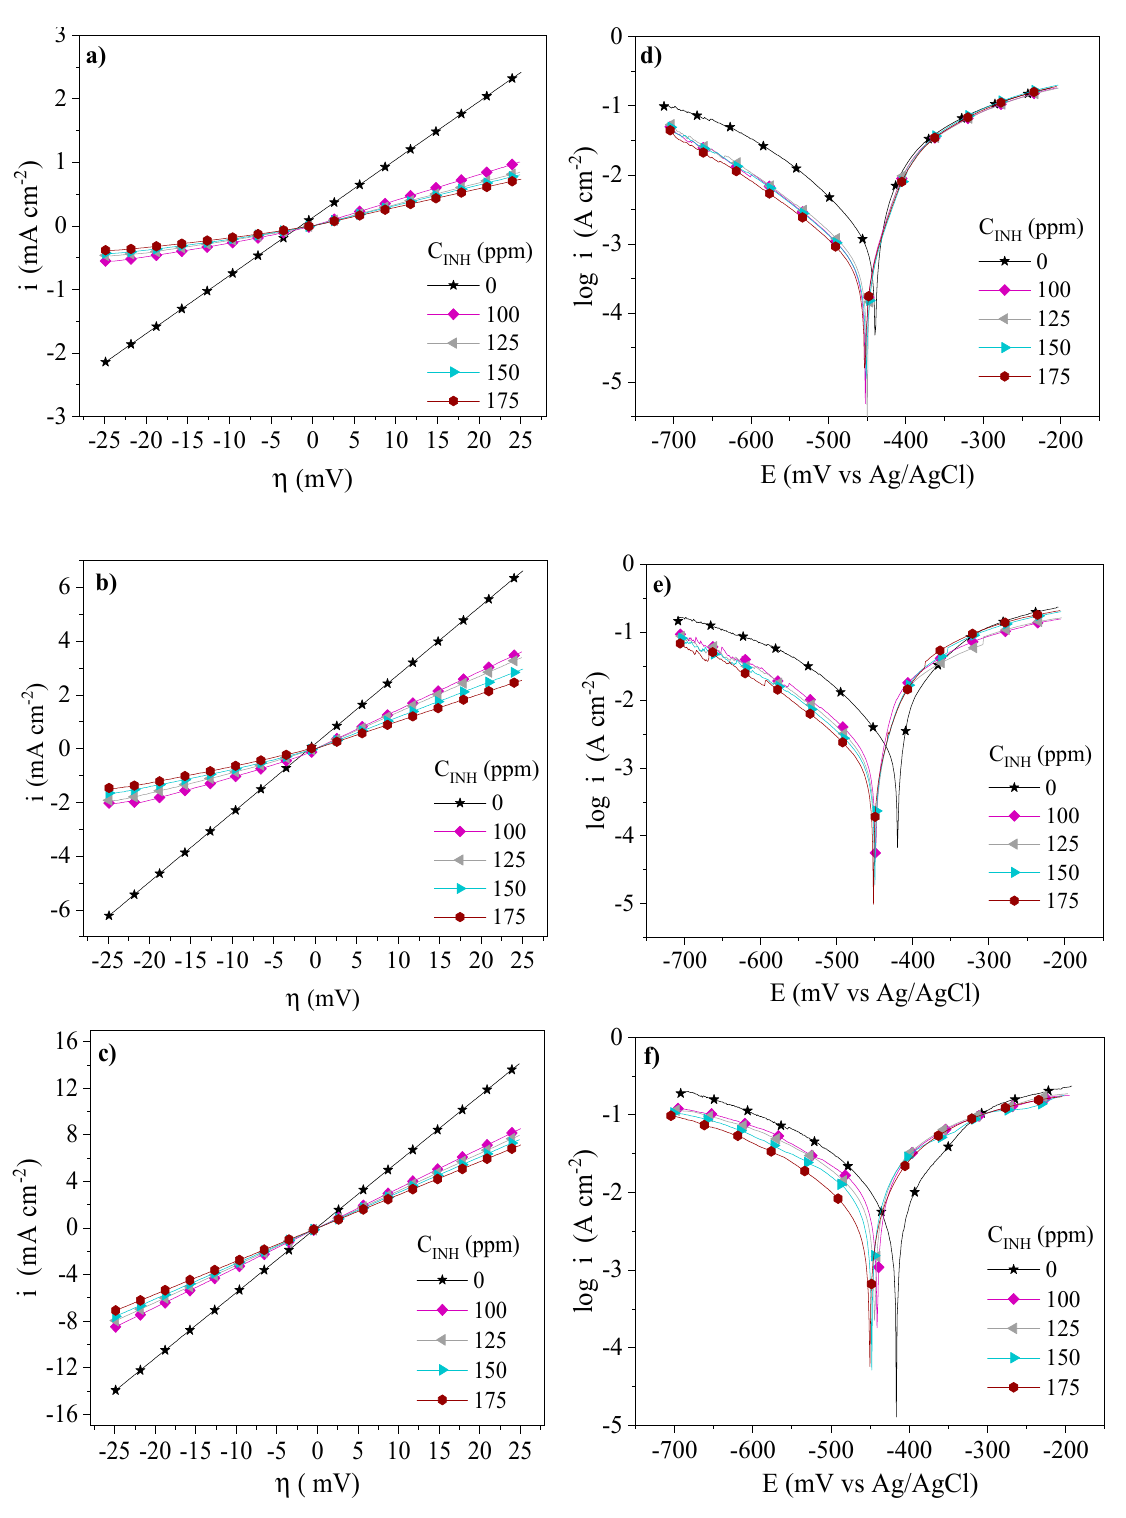
Figure 5. Electrochemical behavior of Poly[VIMC4][Br] as CI of API 5L X60 steel 1 M H 2 SO 4 by the LPR and PDP techniques: ( a ) LPR – 308 K, ( b ) LPR – 318 K, ( c ) LPR – 328 K, ( d ) PDP – 308 K, ( e ) PDP – 318 K, and ( f ) PDP – 328 K. Table 3. Electrochemical parameters of API 5L X60 steel in 1 M H 2 SO 4 —CIs at di ff erent temperatures by the LPR and PDP techniques.